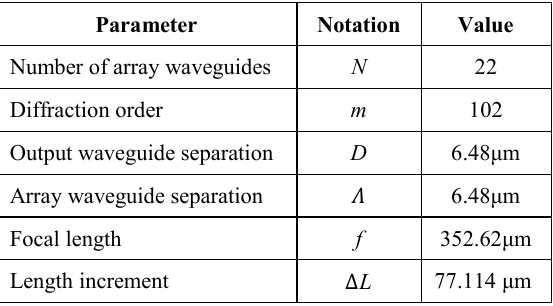
Fig. 1. Schematic of cross-section of a SLSW. Table 1. Design